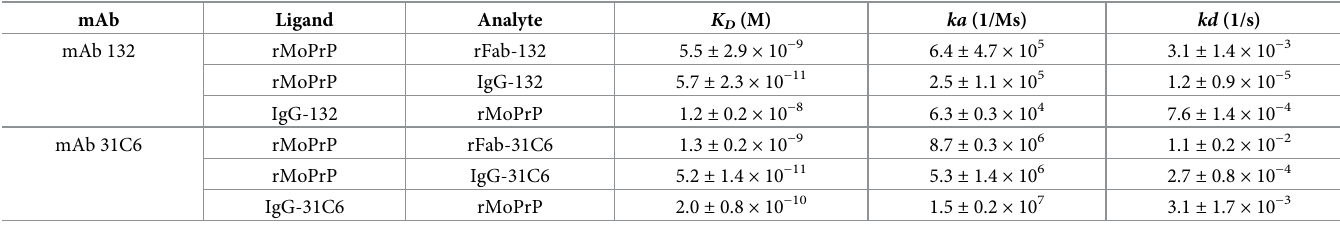
Table 1. Summary of equilibrium and kinetic constants a) .